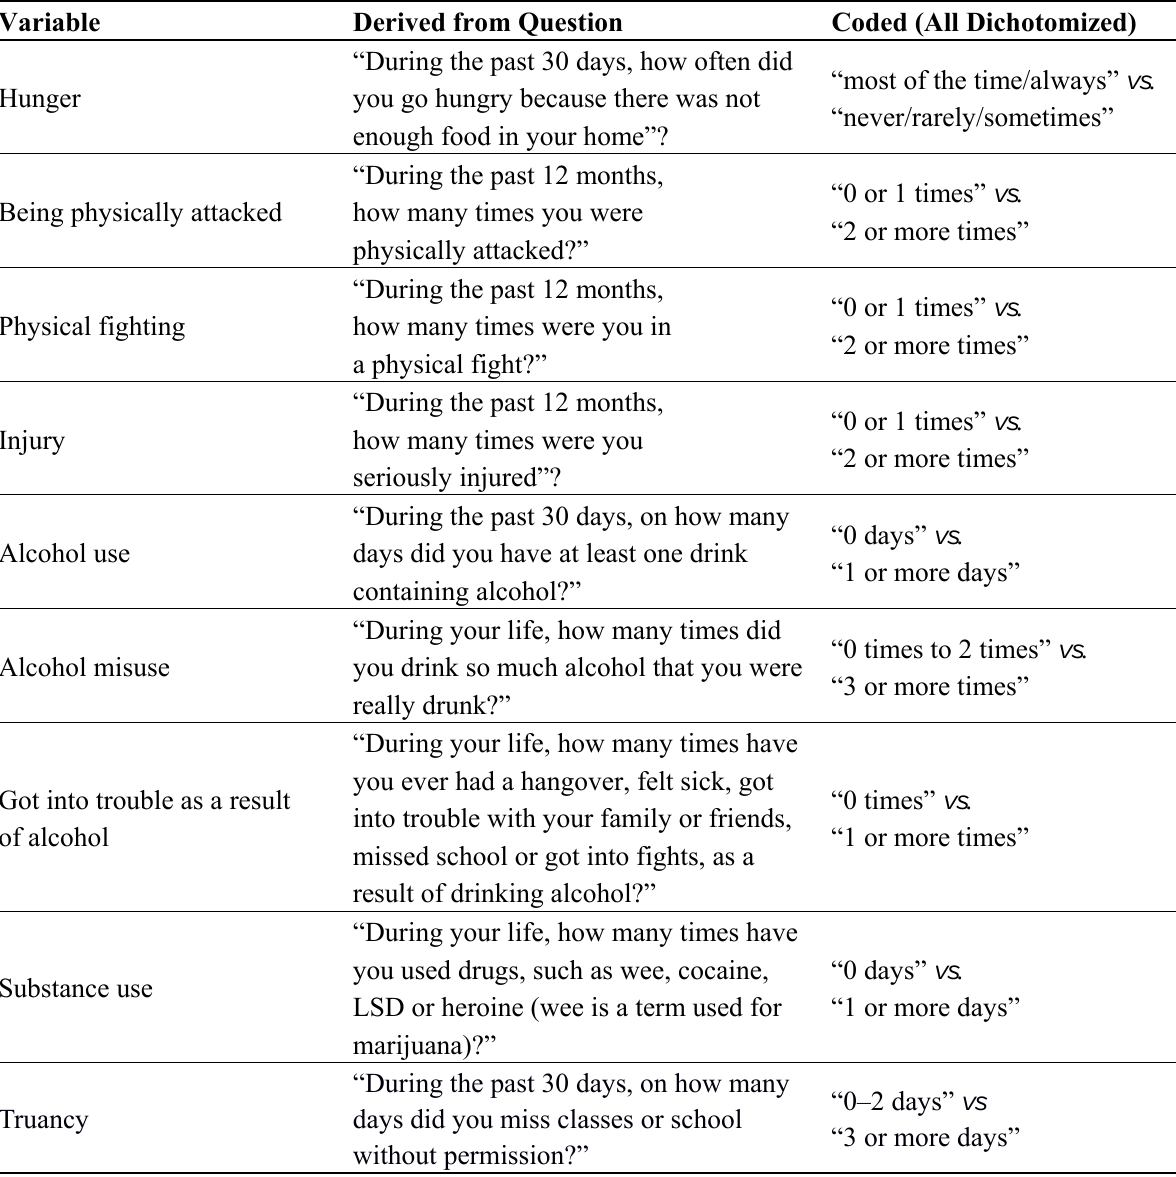
Table 1. Selected independent variables considered in a study of bullying among school-attending adolescents in Ghana